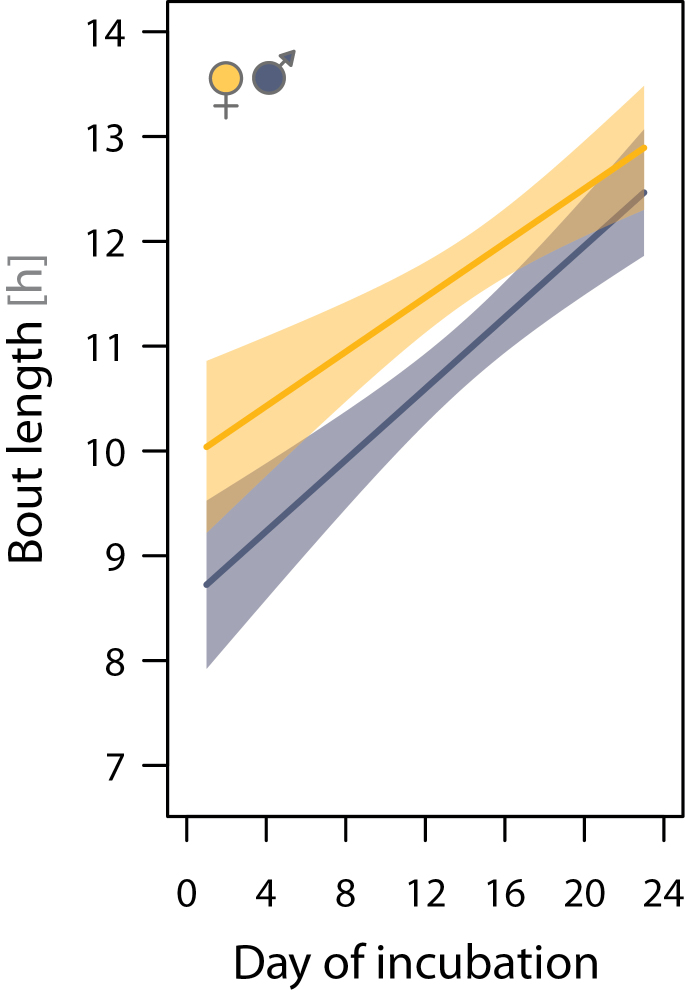
Increase in incubation bout length over the incubation period. The solid lines represent the model fit, and the shading represents the 95% CIs. Model results are presented in Table 3, and the distribution of the raw data is depicted in Supplementary Figure S5.